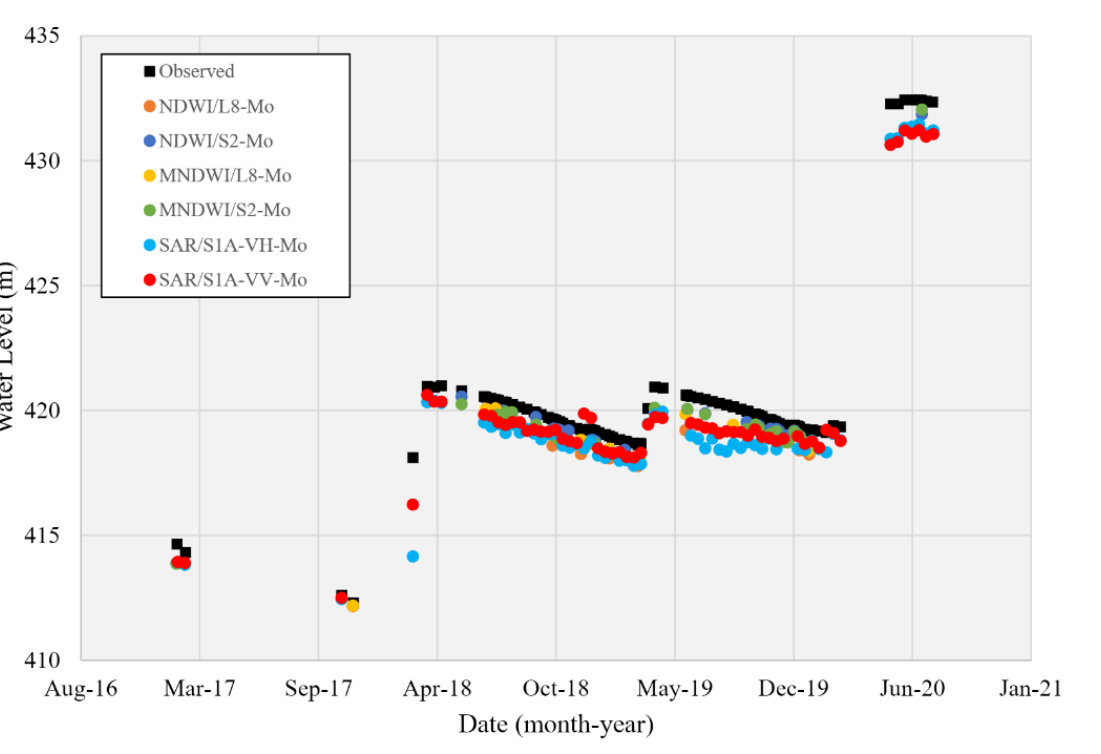
Table 7. RMSE and MPD results in the assessment of hydrological monitoring.